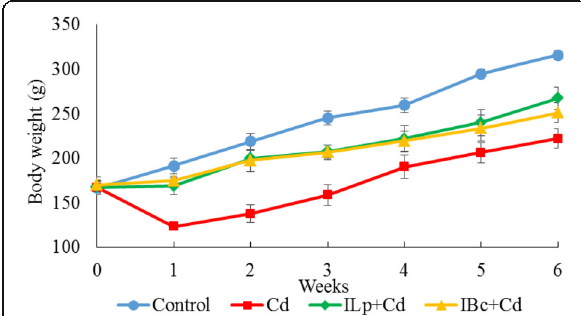
Fig. 1 Effects of oral administration of cadmium on body weight of rat fed synbiotic diets containing inulin, B. coagulans and L. plantarum following 6 weeks of treatment. Cd: cadmium; ILp + Cd: inulin, Lactobacillus plantarum and cadmium; IBc + Cd: inulin, Bacillus coagulans and cadmium. All results are expressed as mean and standard errors of 6 rats in each group